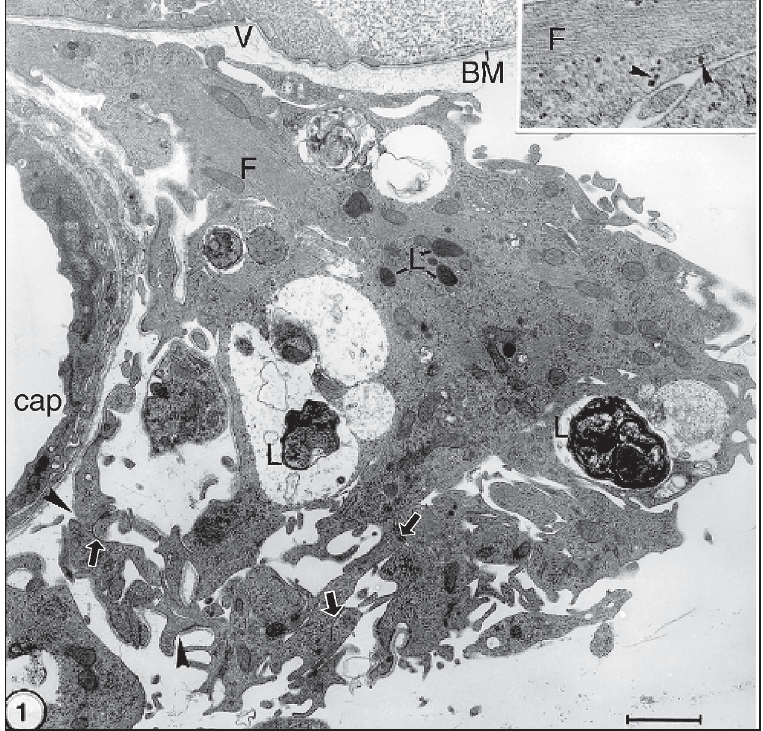
Figure 1. Electron micrograph of the rabbit retina at the site of a glial tuft. Contrast with uranyl acetate and lead citrate. Bar = 1 µm. The regular retina is seen in the upper portion with a continuous inner limiting membrane with its basement membrane (BM) separating the retina from the vitreous body (V). Most of the figure is occupied by a glial tuft. Part of a capillary (cap) is observed on the left. Portions of several astrocytes may be identified by cytoplasmic bundles of intermediate filaments (F). Cell junctions are indicated by arrows. Note lysosomes (L) in the astrocyte cytoplasm. Even at this relatively low magnification, interruptions of the basement membrane around the astrocytes may be observed (arrow- heads). The inset at the upper right corner shows a peripheral process with glycogen granules (arrowheads) close to intermediate filaments (F). 40,000X.